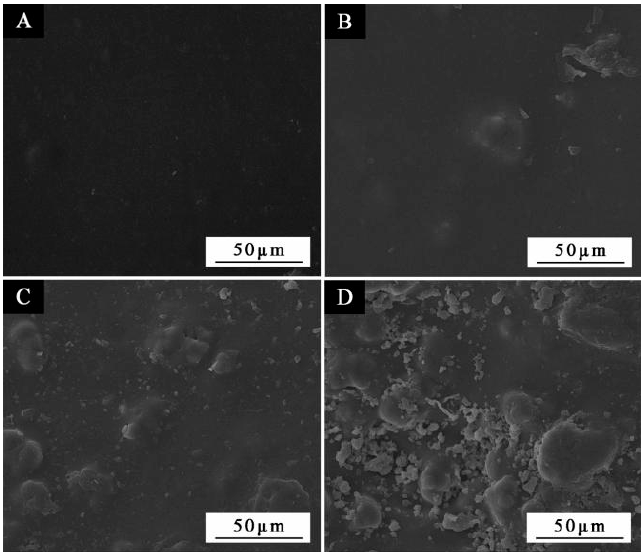
Figure 4. SEM images of waterborne topcoat paint film with different contents of 0.67:1 microcapsules: ( A ) 0; ( B ) 5.0%; ( C ) 10.0%; ( D ) 25.0%.